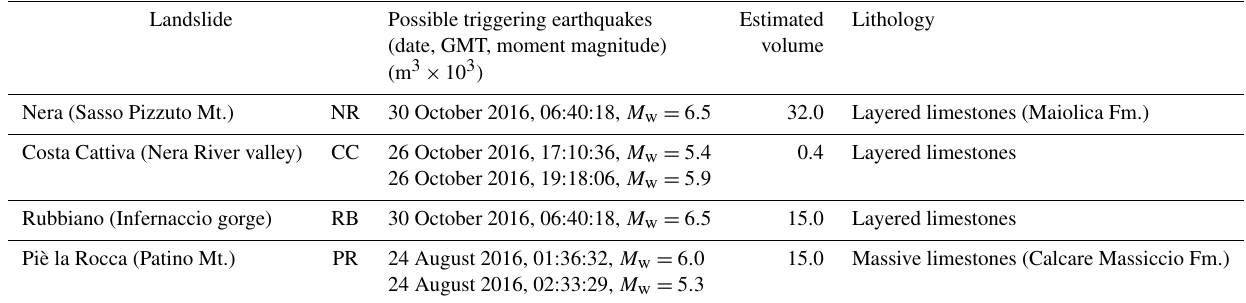
Table 1. Main features of the investigated rockslides. Landslide Possible triggering earthquakes Estimated Lithology (date, GMT, moment magnitude) volume (m 3 × 10 3 ) Nera (Sasso Pizzuto Mt.) Layered limestones (Maiolica Fm.) Layered limestones Rubbiano (Infernaccio gorge) Layered limestones Piè la Rocca (Patino